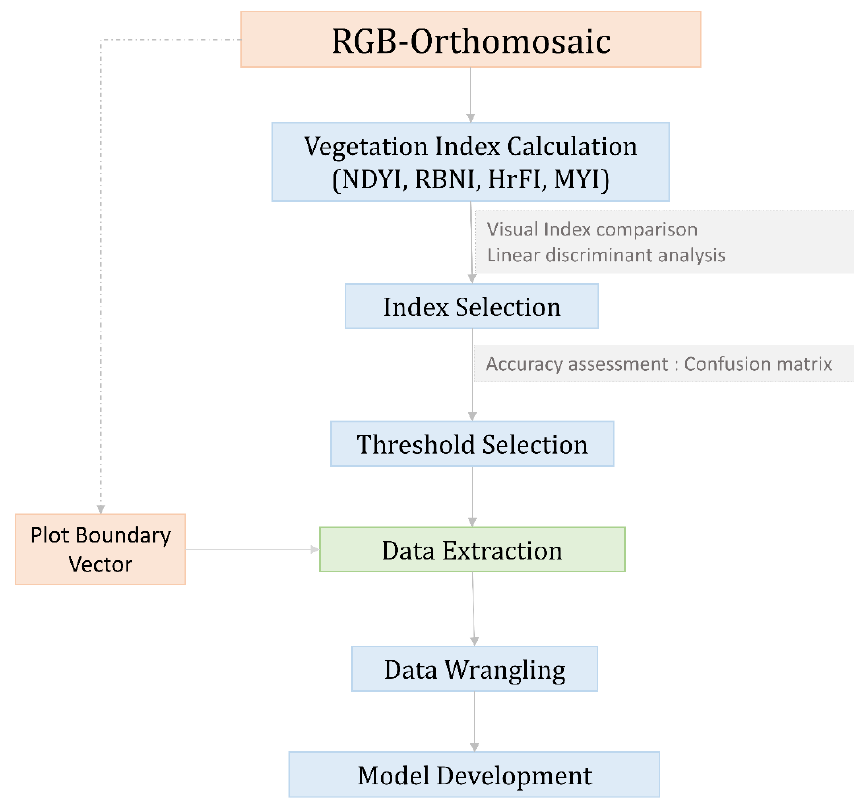
Figure 2. Image processing workflow of the study. NDYI—Normalized Difference Yellowness Index, RBNI—Red Blue Normalizing Index, HrFI—High-resolution Flowering Index, MYI—Modified Yellowness Index.